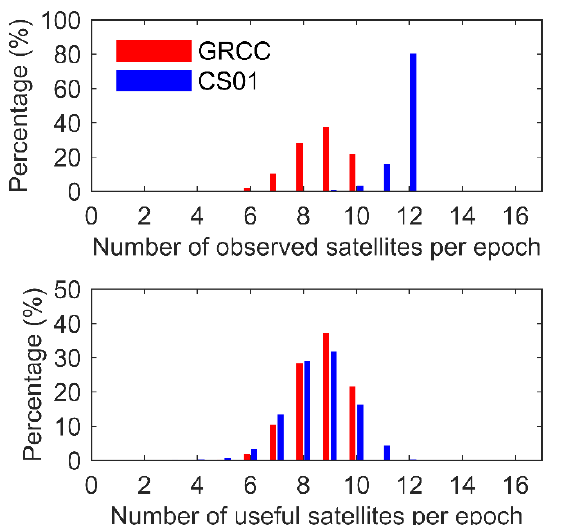
Figure 1. Average percentage of observed ( top ) and useful ( bottom ) GPS satellites for GRCC and CS01.